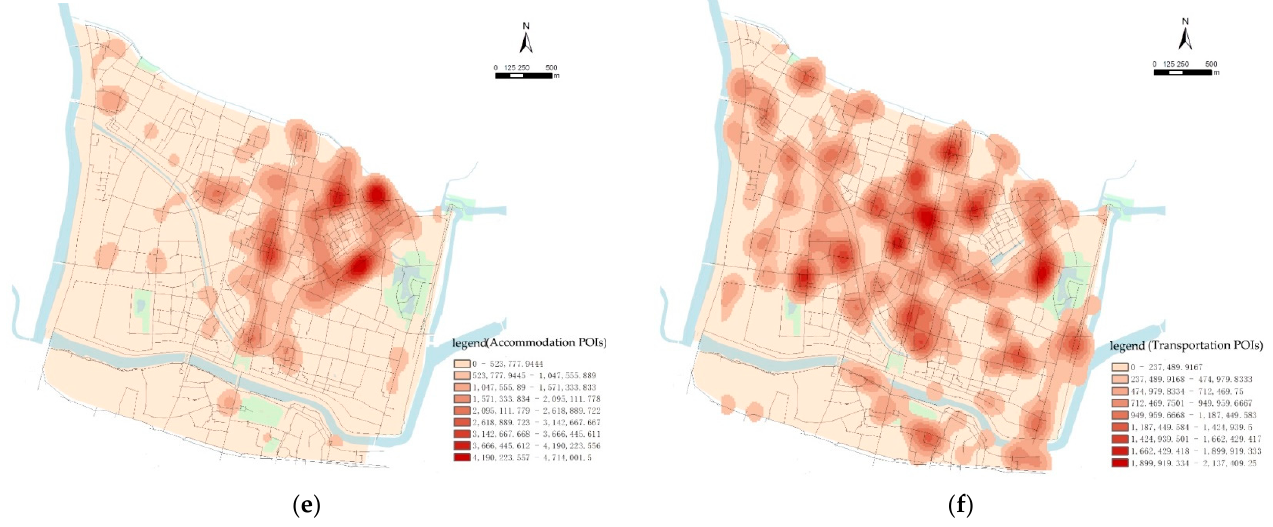
Figure 3. Spatial distribution of tourism service POIs: ( a ) tourism service POIs; ( b ) shopping POIs; ( c ) catering POIs; ( d ) entertainment POIs; ( e ) accommodation POIs; ( f ) transportation POIs.